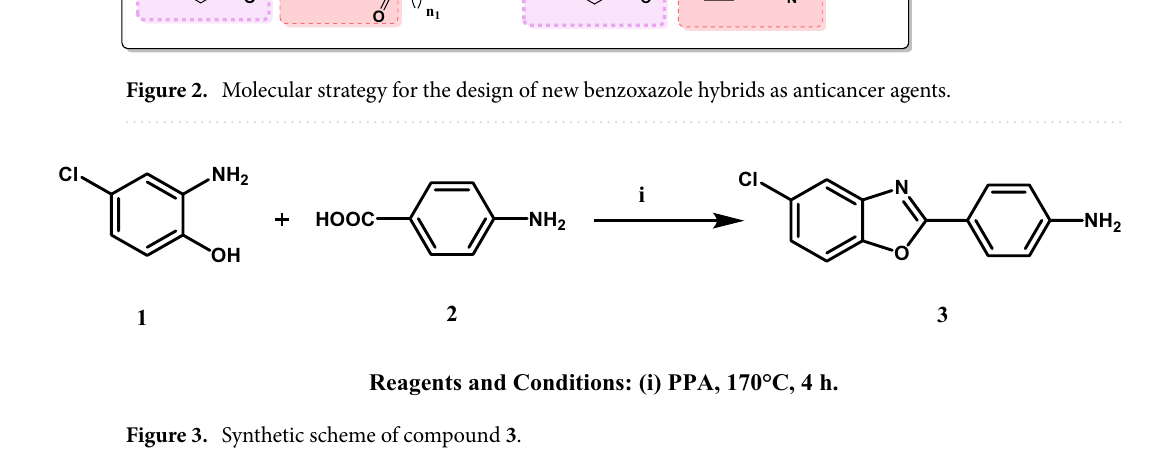
Figure 3. Synthetic scheme of compound 3